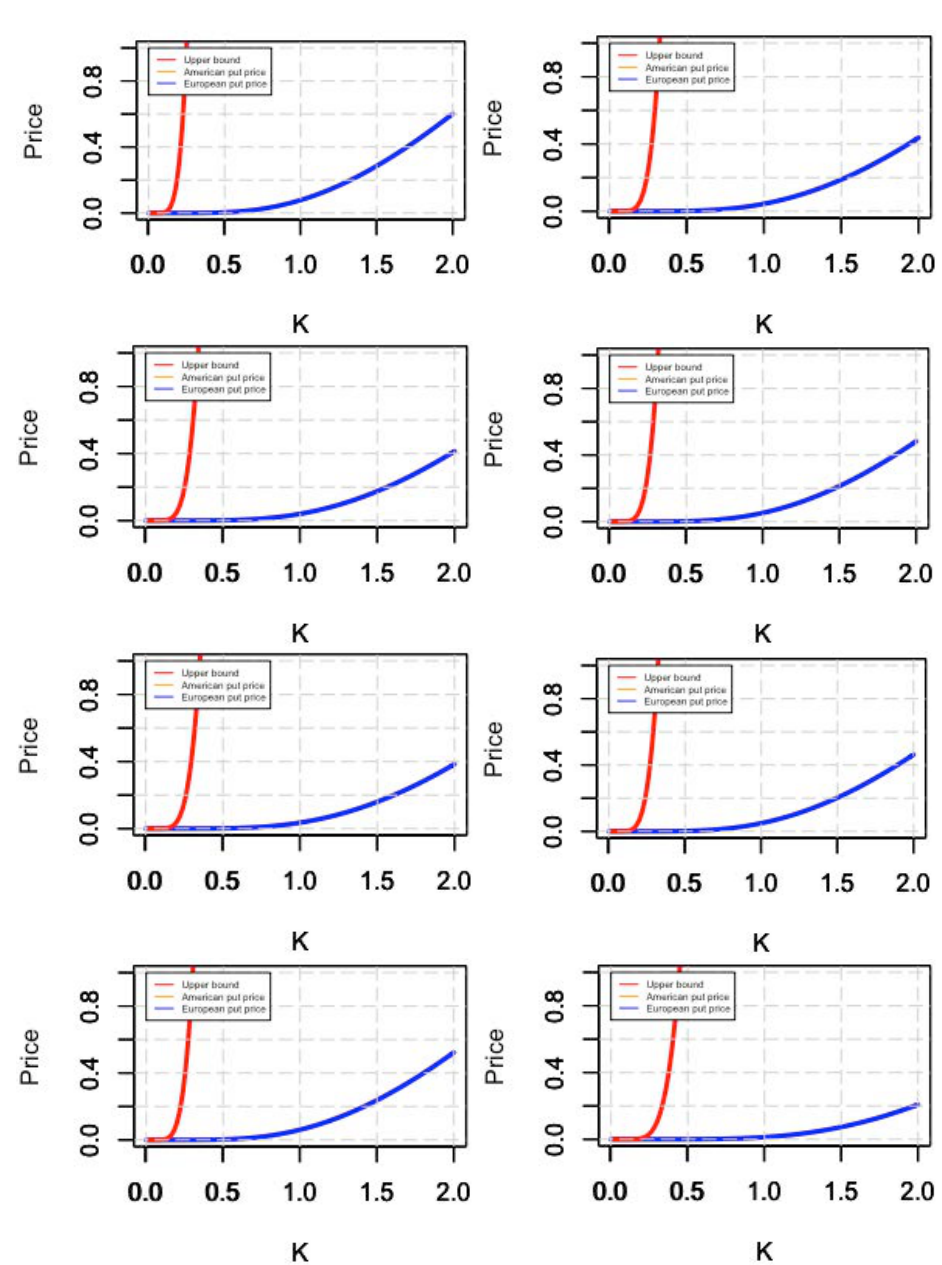
Figure 4. Put option prices written on FNMA during COVID-19. The figure shows the price of American options (yellow lines), European options (blue lines), and bounds for optima